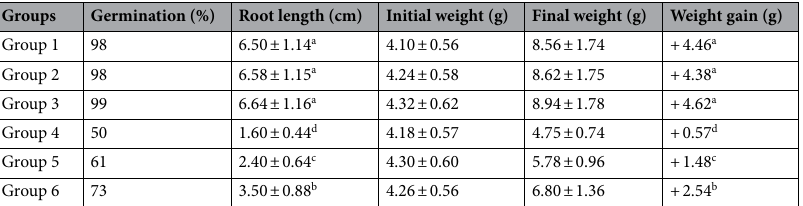
Table 2. Physiological changes caused by diniconazole and CME. *Group 1: Control, Group 2: 0.5 g/L CME, Group 3: 1.0 g/L CME, Group 4: 100 mg/L diniconazole, Group 5: 0.5 g/L CME + 100 mg/L diniconazole, Group 6: 1.0 g/L CME + 100 mg/L diniconazole. The averages shown with different letters (a–d) in the same column are statistically significant (p < 0.05).